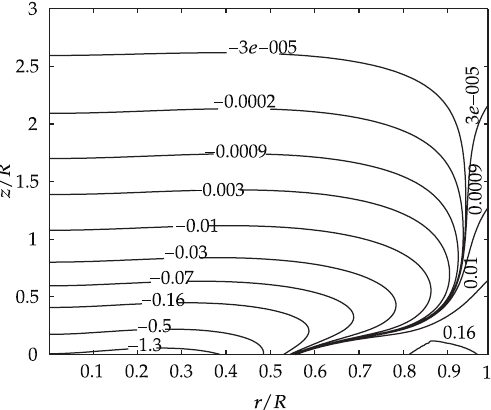
Figure 4: Distribution of the stress σ θ / (cid:6) σ 0 (cid:7) in the end condition example.